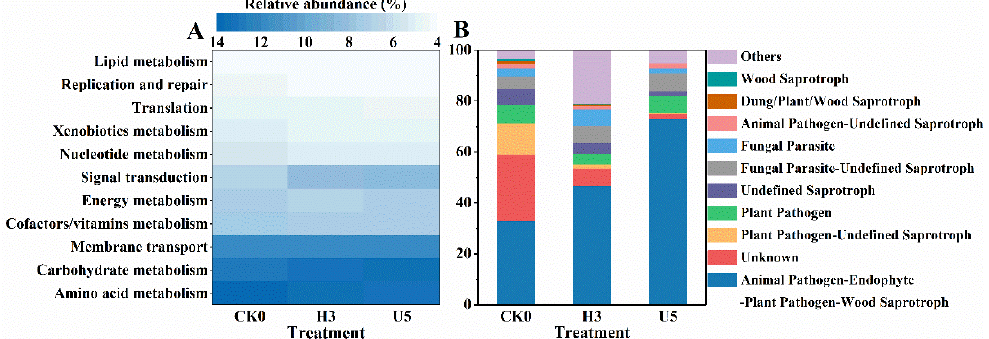
Figure 6. Functional predictions and comparisons among different treatments: ( A ) relative abundance (%) of main level 2 Kyoto Encyclopedia of Genes and Genomes (KEGG) orthology groups based on Tax4Fun; ( B ) relative abundance (%) of major fungal guilds screened by FUNGuild. Values were presented as the mean ( n = 3).